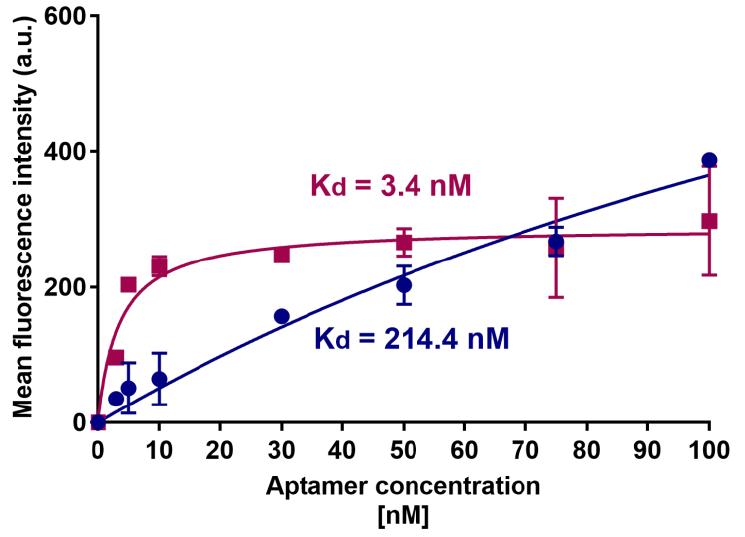
Figure 4. Determination of the equilibrium dissociation constant ( K d ) of candidate aptamers Apt1 and Apt1_RC. The titration curves of each aptamer with E. coli UspA2 cells are shown. The aptamers were labeled with fluorescein (FAM) and fluorescence was assessed with a fluorescence spectrophotometer. K d (nM) values were calculated using GraphPad Prism 7, set to a non-linear fit model with one-site non-competitive binding to the fluorescent population ratio at the given aptamer concentrations. a.u = arbitrary units.